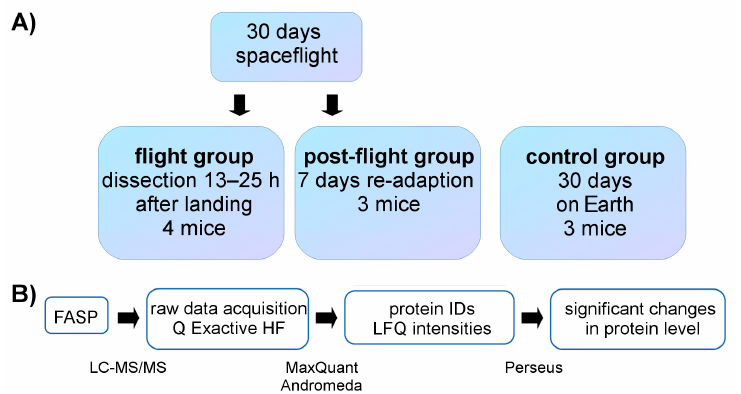
Figure 1. Sample overview and methodological workflow. ( a ) Sample overview for all three groups investigated. The control group on Earth was held in housing and climate conditions corresponding to the conditions of flight group; ( b ) Workflow of sample preparation, processing, and